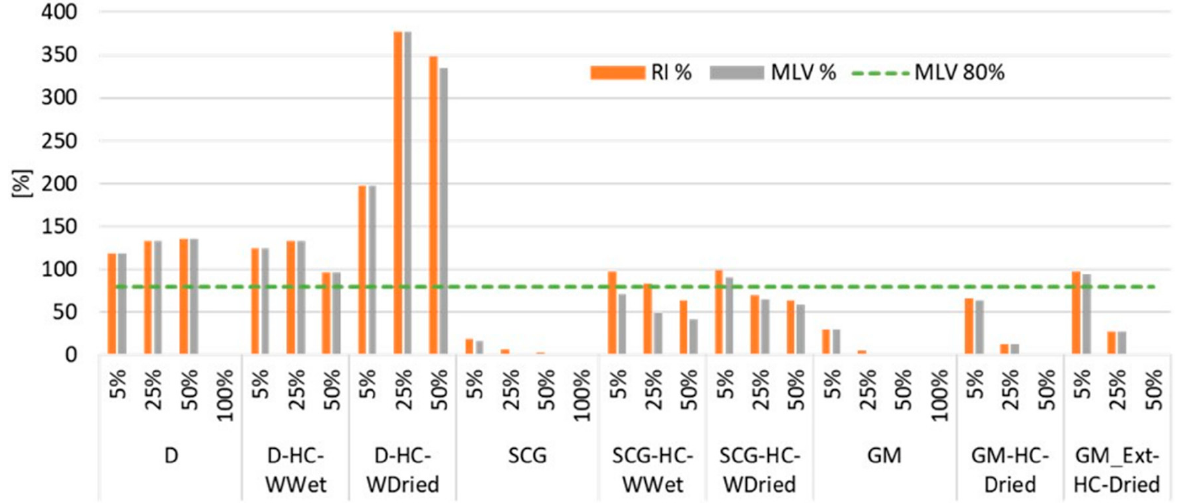
Figure 5. Values of root length index (RI), and Munoo-Liisa vitality index (MLV) calculated for each sample in germination tests with the contact method. The results are expressed relative to the controls (100%).